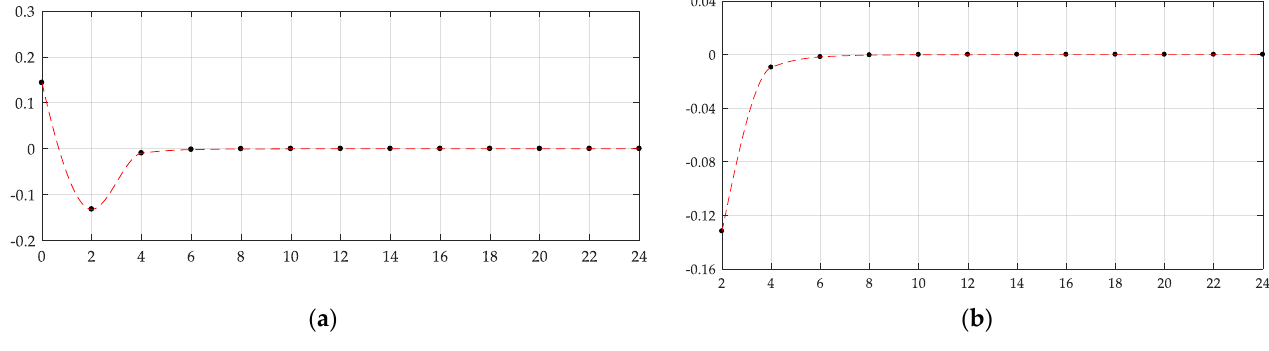
Figure 8. The values of d when = n 24 : ( a ) for = i 0,2,4,6,...,24 ; ( b ) for = i 2,4,6,...,24 .